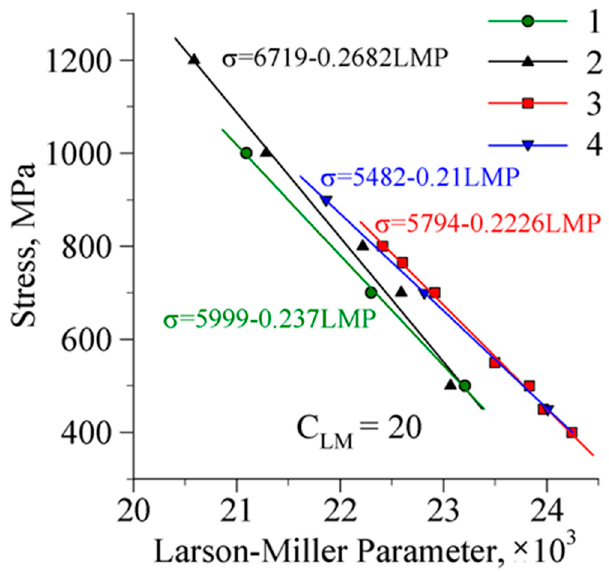
Figure 7. Larson-Miller parameter plotted for the superalloy in conditions 1–4.